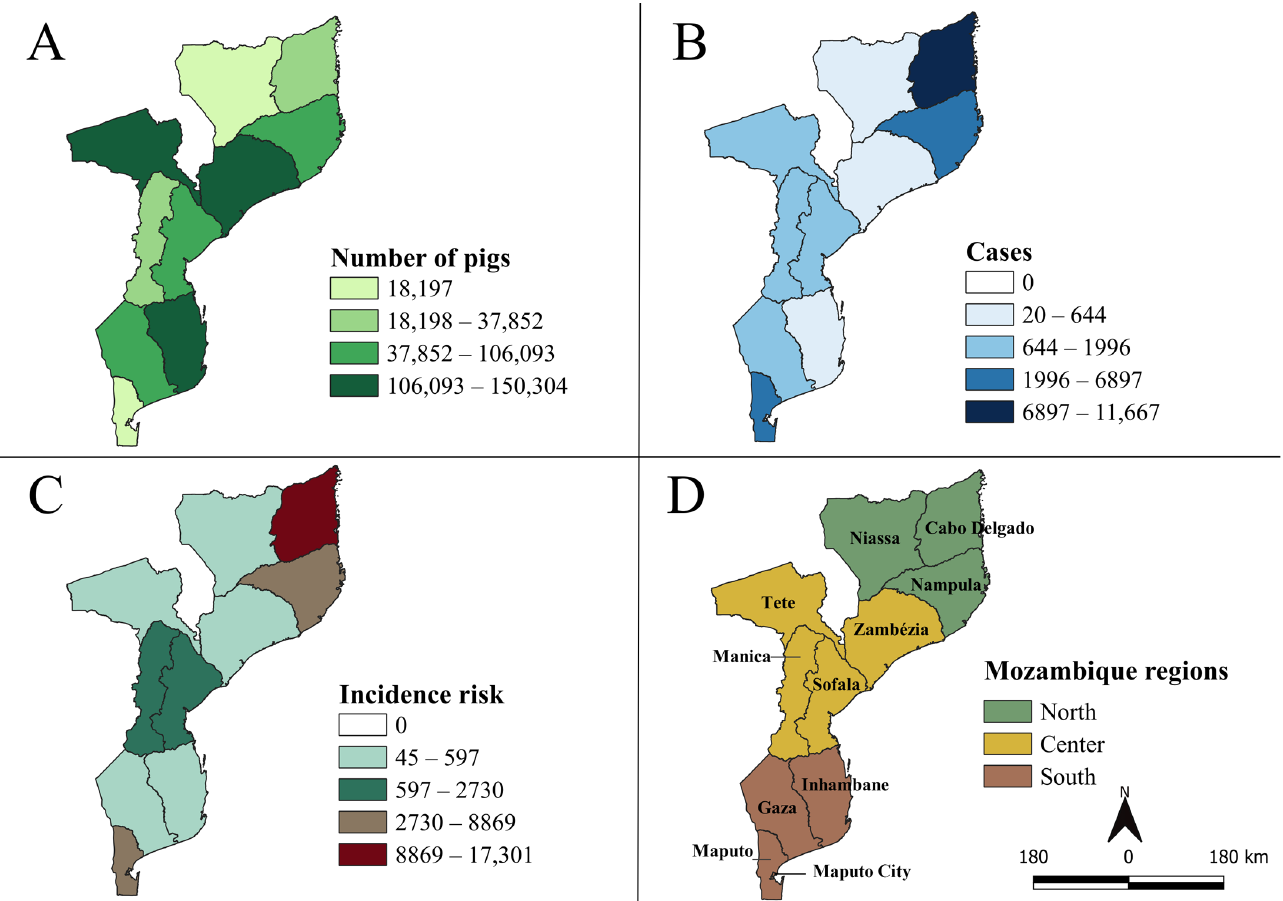
Figure 2. Spatial distribution of the average swine population ( A ); the total number of accumulated African swine fever (ASF) cases ( B ); incidence risk of ASF per 100,000 pigs ( C ); political division of Mozambique ( D ) between 2000 and 2020. Table 1. The total number of cases, relative frequency (RF), and incidence risk (IR) of African swine fever in pigs in different regions and provinces of Mozambique between 2000 and 2020. Regions/Provinces